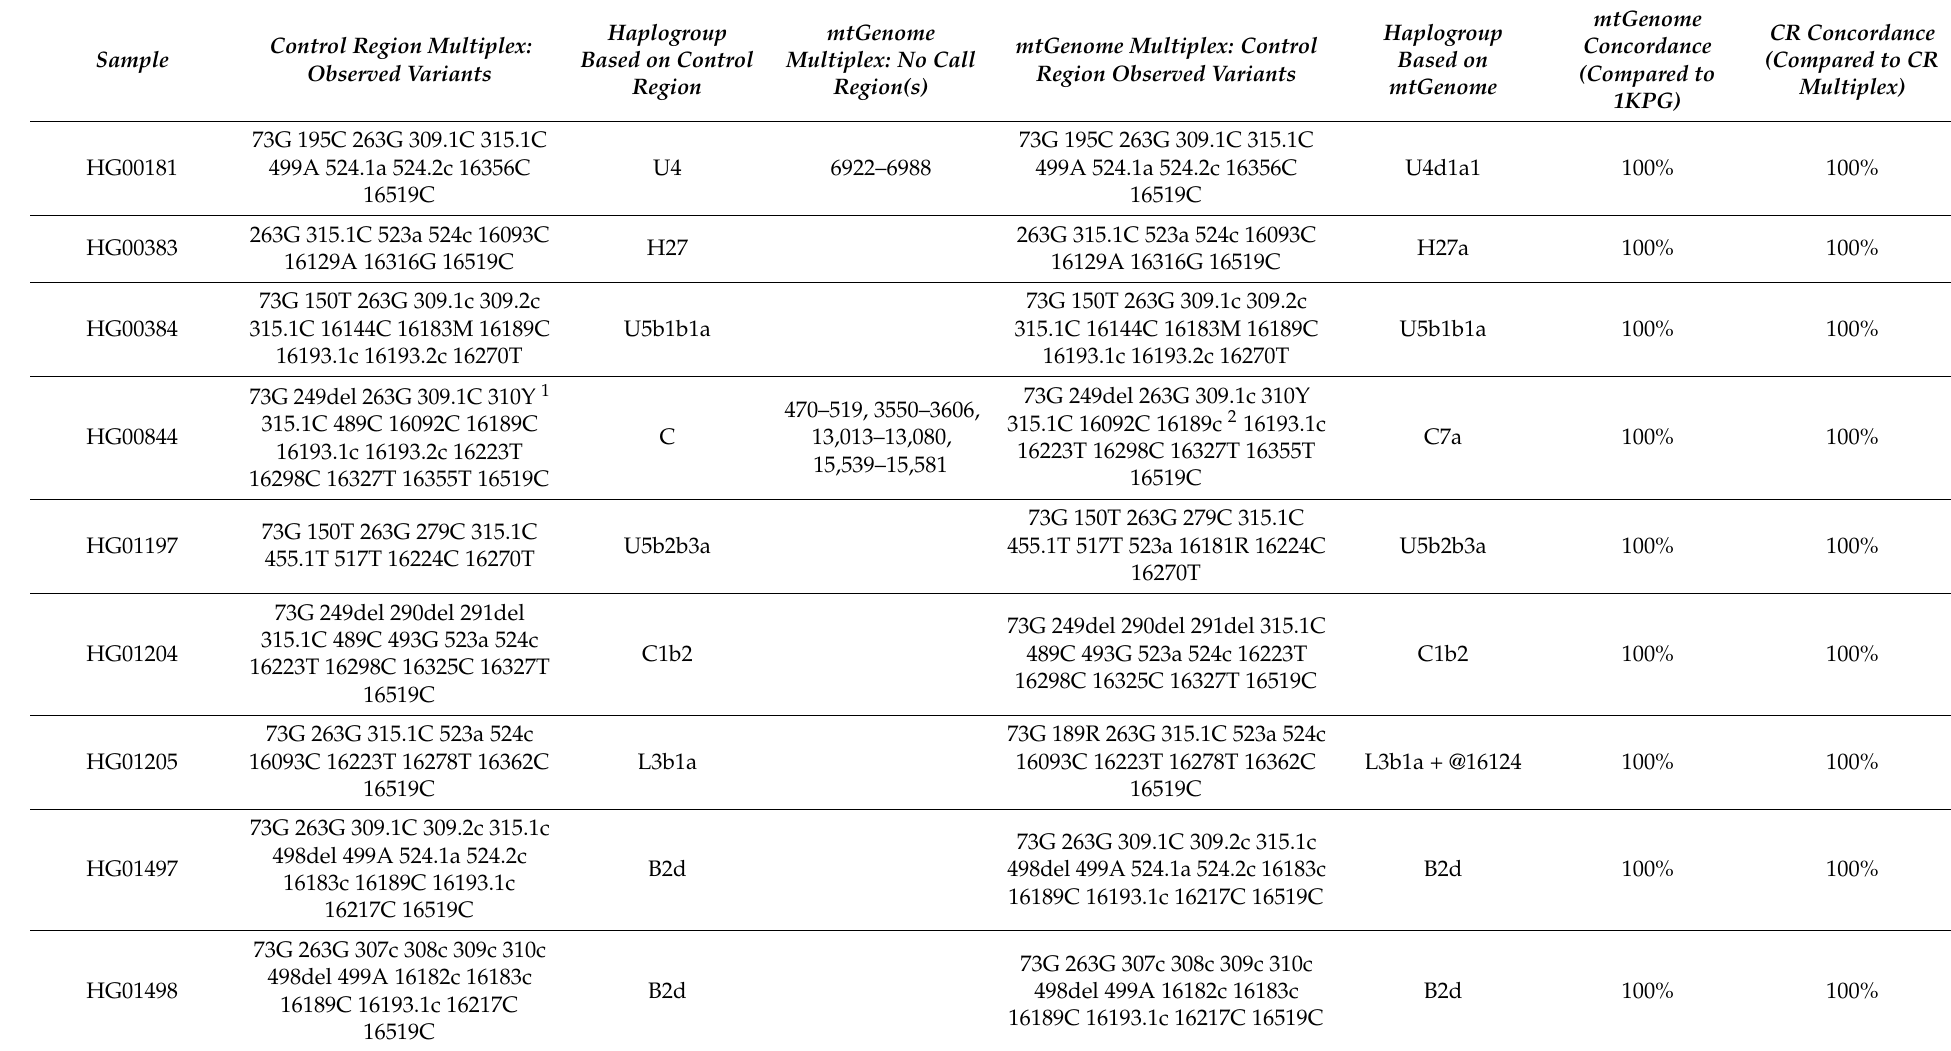
Table 6. Concordance studies: orthogonal WGS data vs. ForenSeq mtDNA multiplexes, haplogroup assignment using